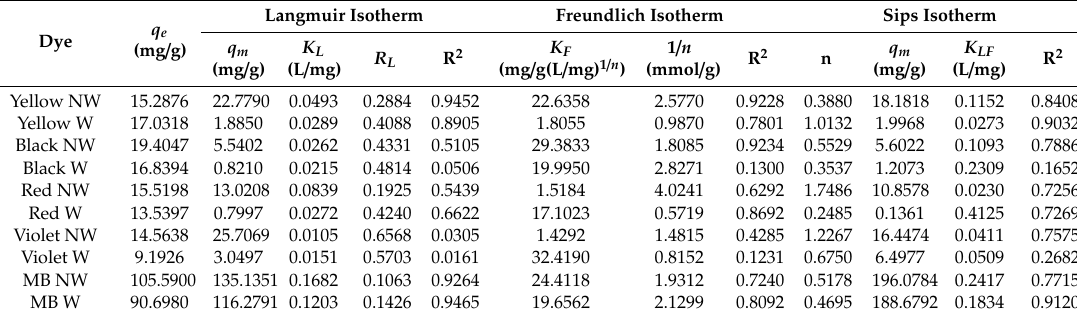
Table 2. Isotherm parameters of di ff erent models for various dyes adsorption on the not washed (nw) and washed (w) digestate